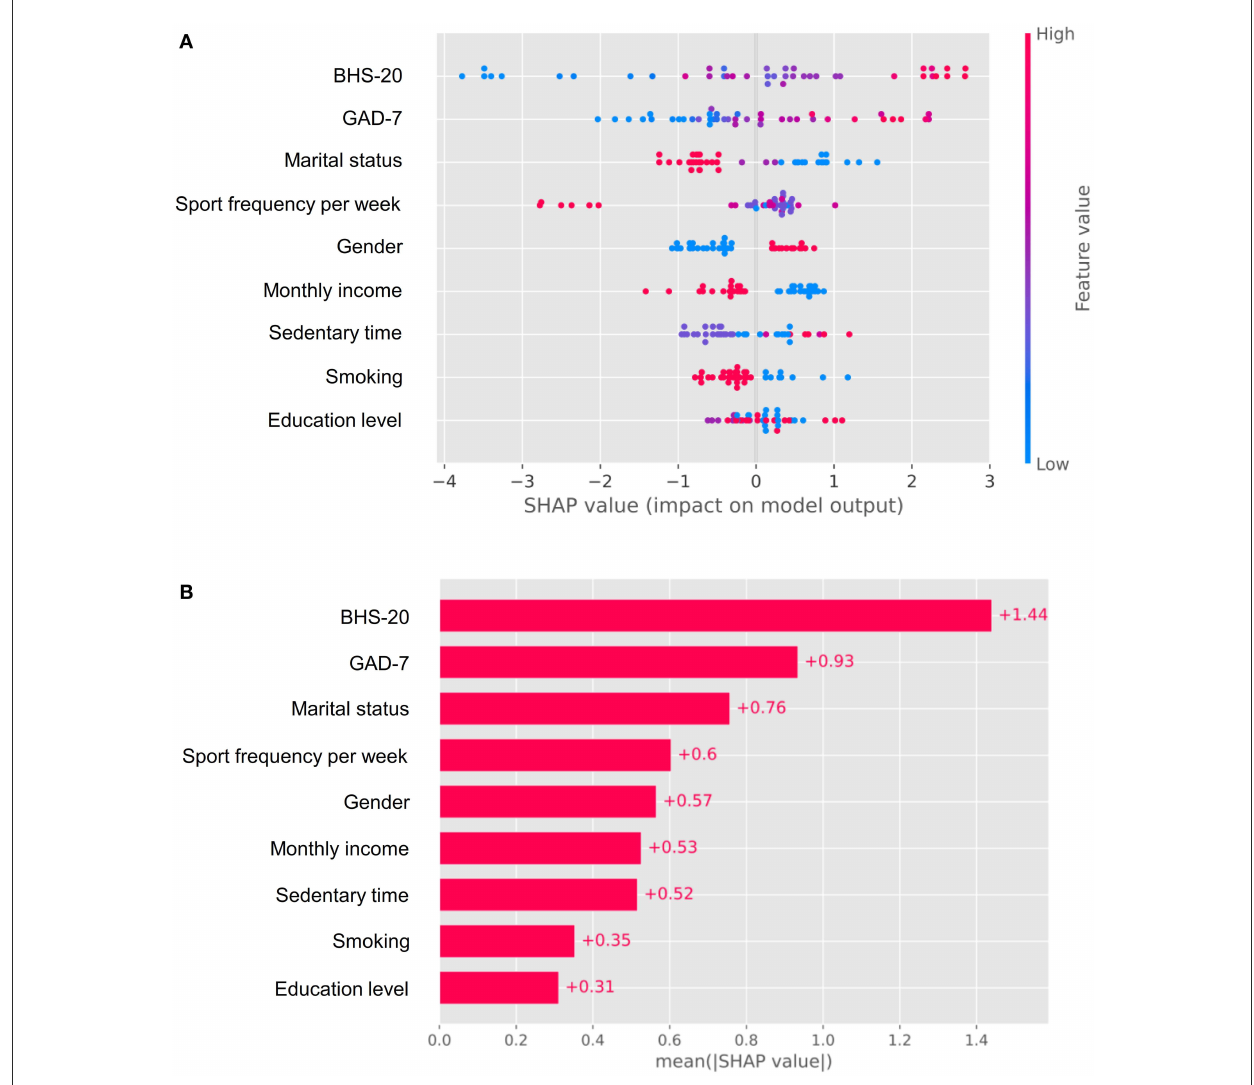
FIGURE6 Feature importance analysis. (A) Bees warm plot; (B) bar plot based on SHAP value.